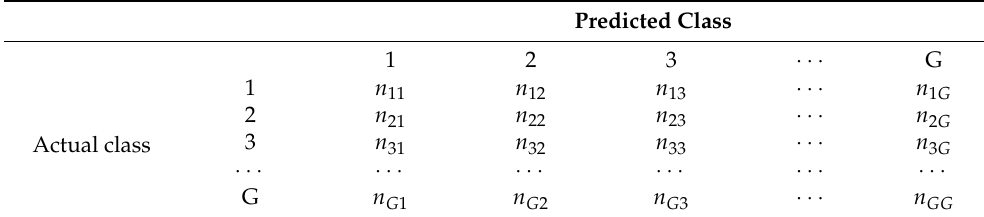
Table 2. Multiple classification confusion matrix.